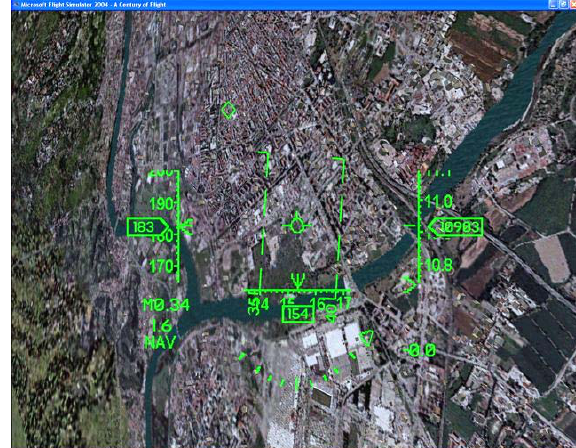
Fig 11. Example of HUD placed on 3D flight